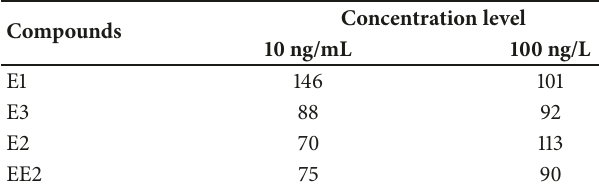
Table 5: Percentage recovery of